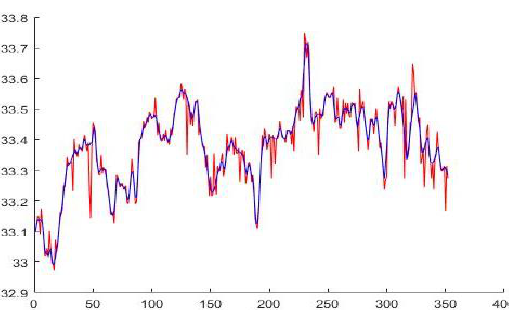
Figure 4. Snapshots of face tracking procedure.